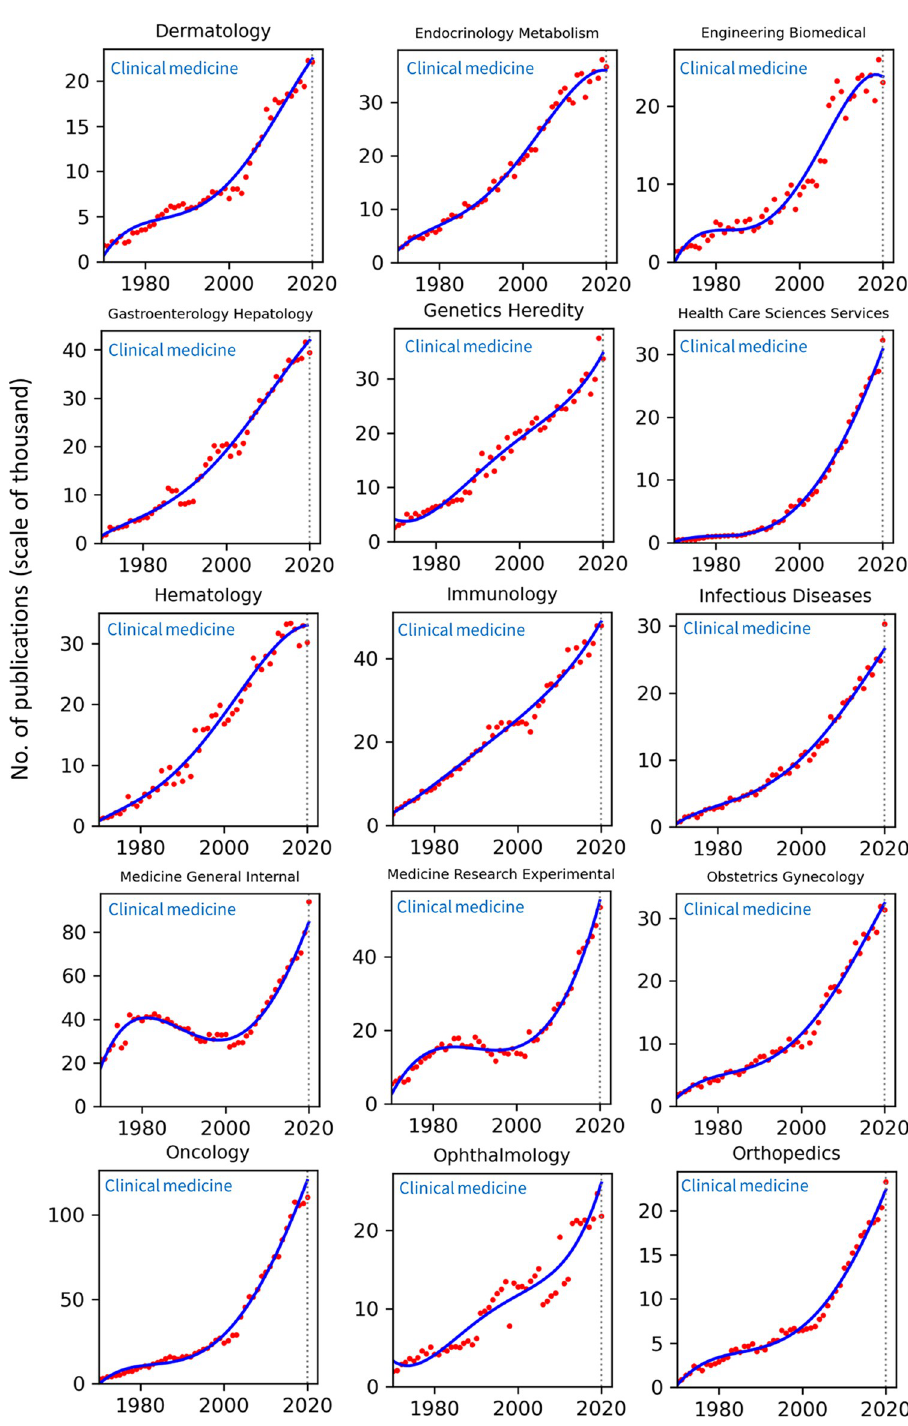
Fig 4. Temporal trends of research productivity in various scientific disciplines (part 3).